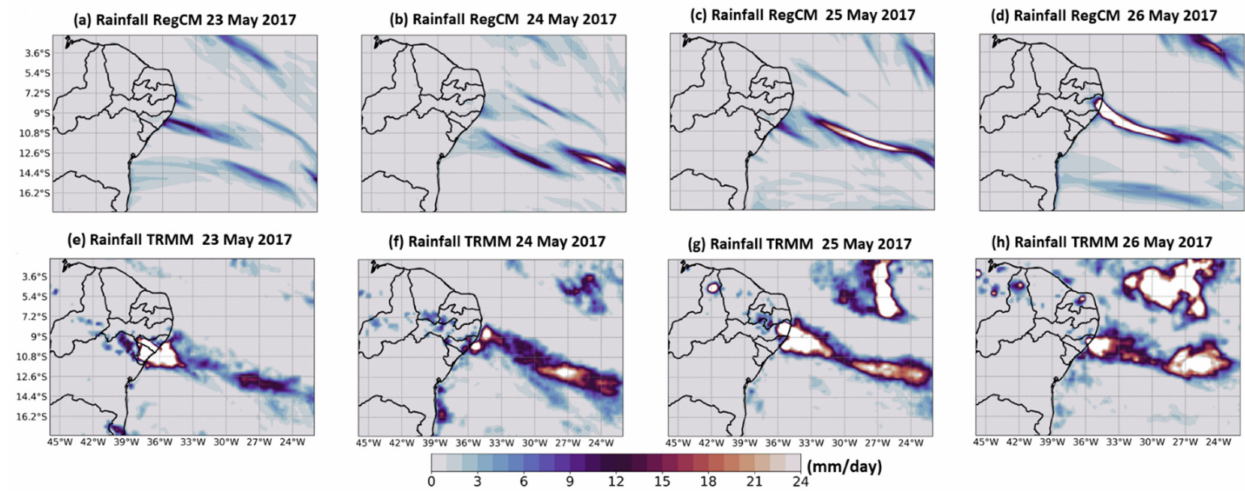
Figure 14. Spatial patterns of daily rainfall at the ECNEB during the period from 23 to 26 May 2017. The images ( a – d ) correspond to rainfall simulated by the RegCM model. The images ( e – h ) correspond to the rainfall obtained by the TRMM satellite.